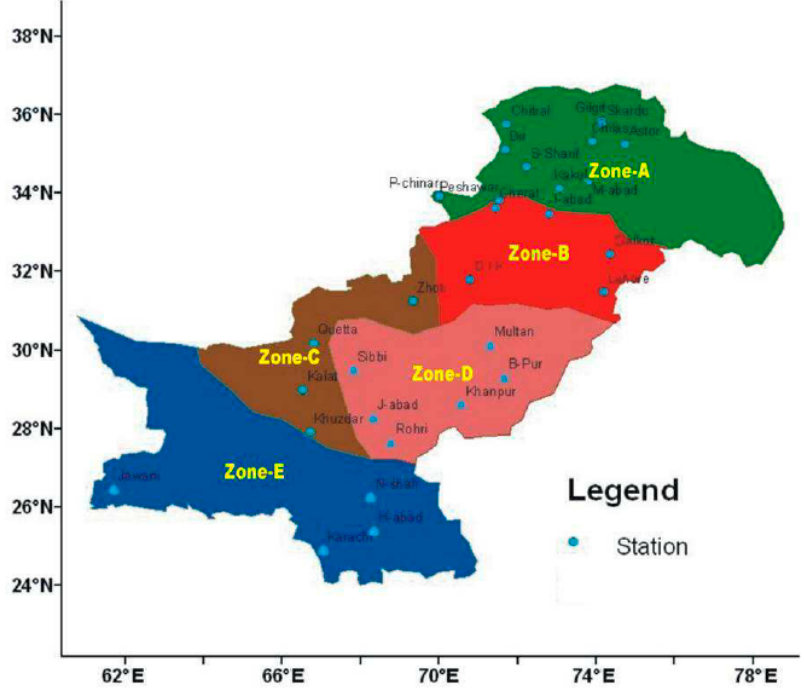
Figure 6. Map of Pakistan Showing different climate zones of Pakistan along with their latitude and longitude. Zone A: High mountains, cold weather; Zone B: Sub-mountains and mildly cold; Zone C: Cold winter and hot summer; Zone D: Hottest and dry zone, where highest max temp are recorded; and, Zone E: Warm humid sub-tropical climate mostly coastal cities.